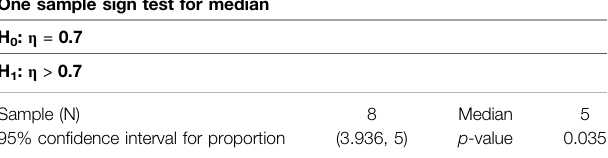
TABLE 6 | Hypothesis test for LDA topic model. One sample sign test for median